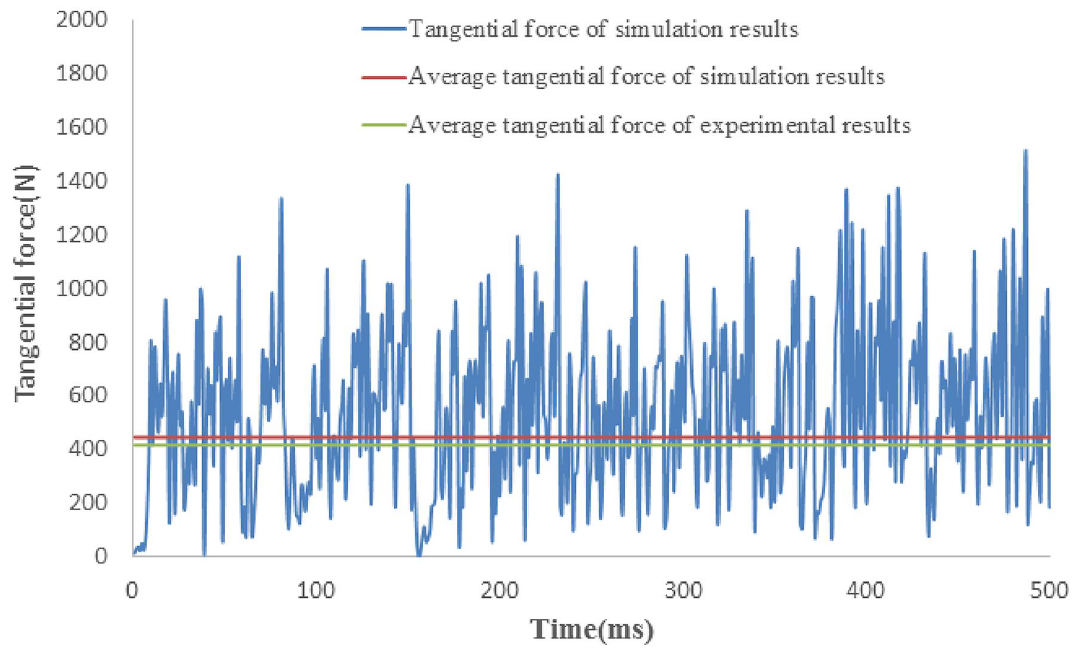
Fig. 7 Comparison of experimental and simulated tangential force results